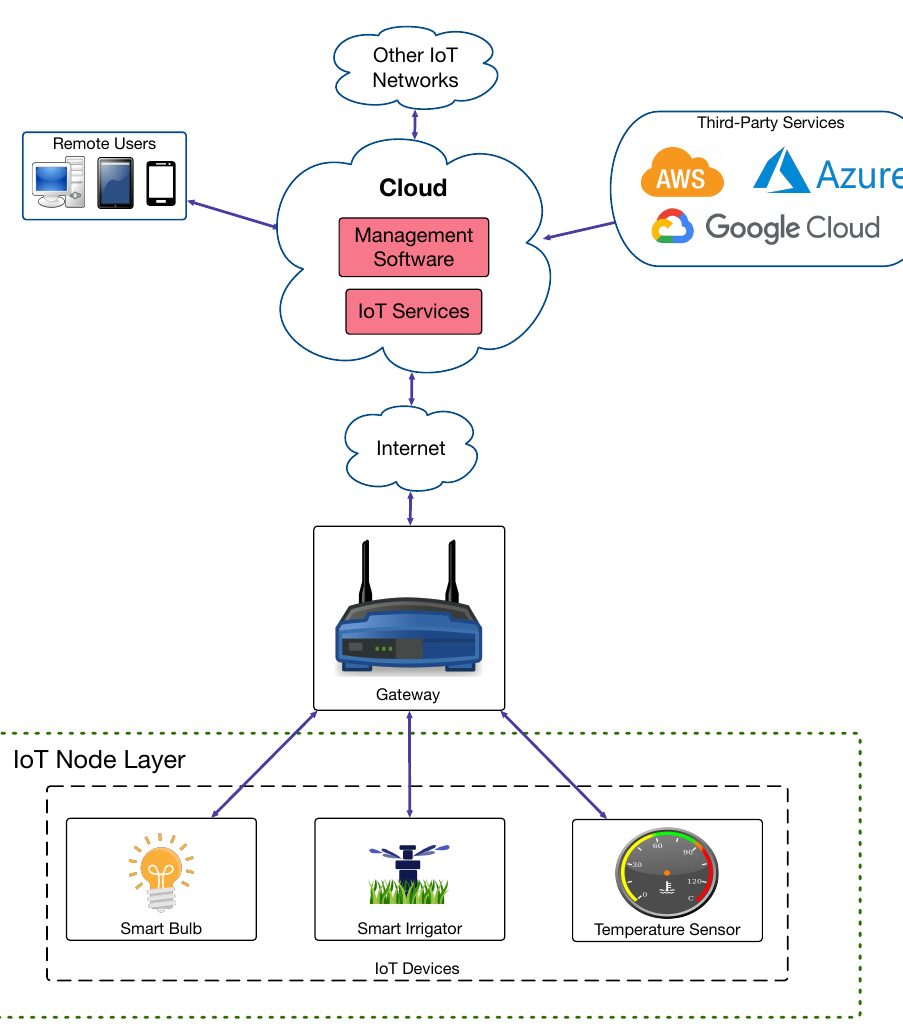
Figure 2. Cloud-based IoT